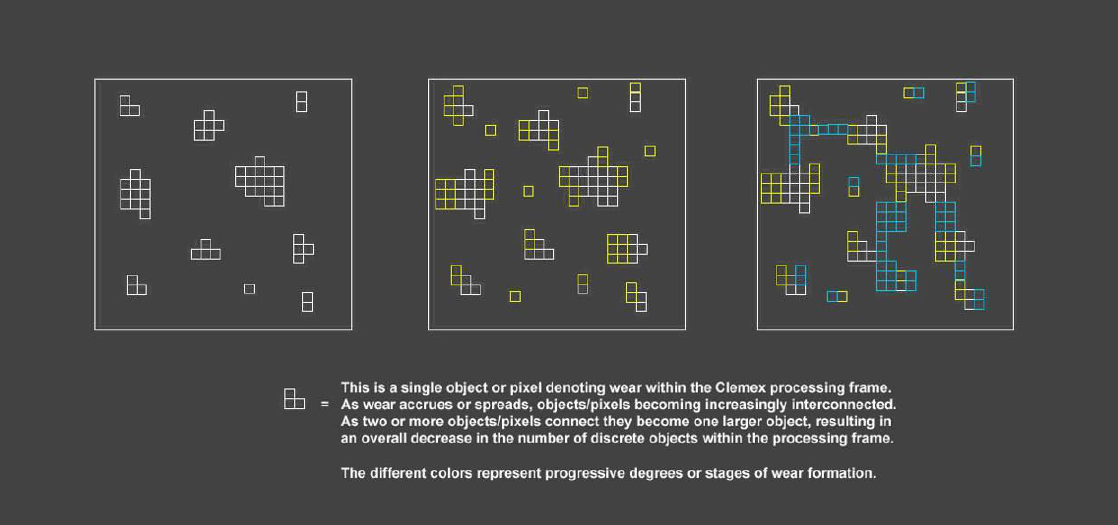
Figure 5: An illustration of how Clemex records the density of objects within the processing frame. Finally, average intensity , is the sum of individual gray values (1 to 256 in a grayscale image) for all pixels associated with wear divided by the total number of pixels within the processing frame. Average intensity is measured on a scale from 0 to 100, where 0 indicates the pixels in question are pure black and 100 indicates the pixels are pure white. All shades of gray, hence all levels of light reflectivity, fall somewhere in between. Visible wear was digitally highlighted relative to the surrounding tool surface through the use of histogram-based thresholding. Thresholding or image segmentation was used to differentiate pixels associated with use-related wear from pixels that denote unworn portions of a tool’s surface. The threshold histograms in Clemex are based on individual pixel gray values that range from 0 (black) to 255 (white) and together comprise the full spectrum of a standard 256 grayscale image. Each bar in the histogram represents a range of four consecutive pixel gray values (e.g. 0-3, 4-7,